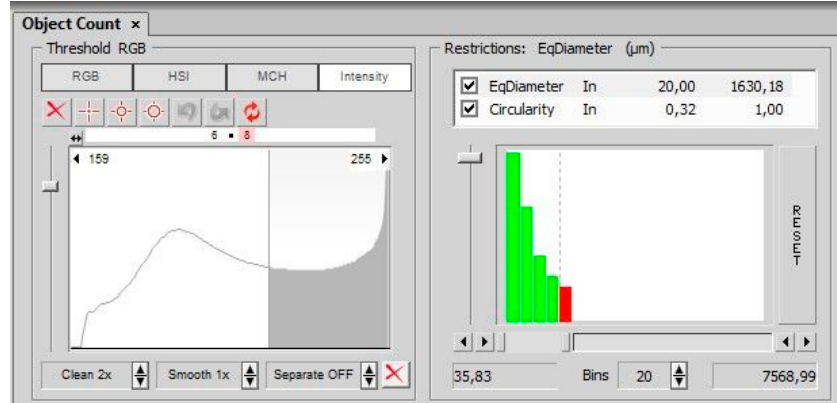
Figure 3. NIS Elements window with marked threshold ( left ); sand particle equivalent diameter histogram ( right ).